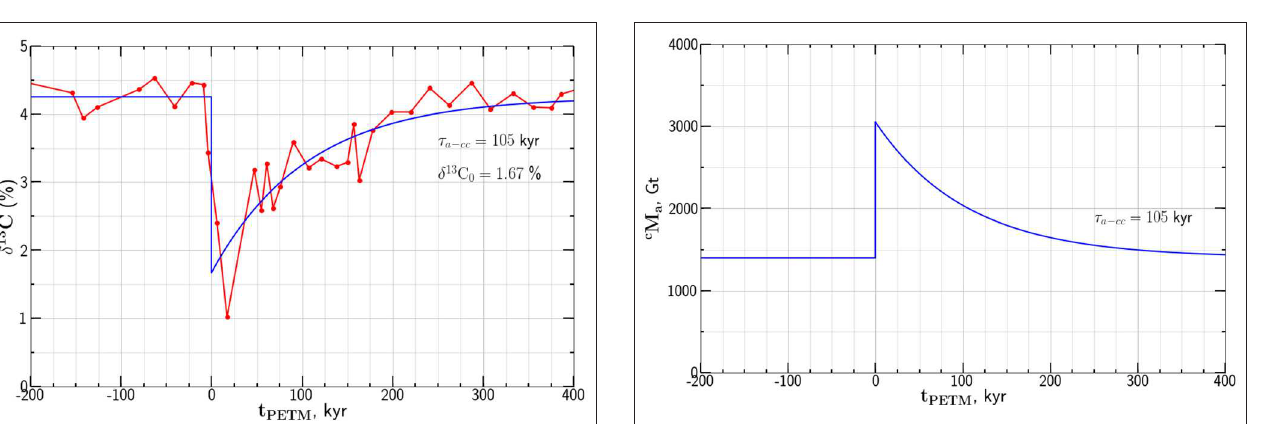
FIGURE 5 | An example of the carbon isotope anomaly associated with the PETM. The dependence of the δ 13 C values on depositional time t PETM relative to the onset of the anomaly are given. The data are from the DSDP site 401 with the carbon in foraminifera M. subbotinae ( Gutjahr et al., 2017). Also shown is the least squares best fit of our relaxation model from Equation (12) with relaxation time τ a − cc = 105 kyr and δ 13 C 0 = 1.67 % .